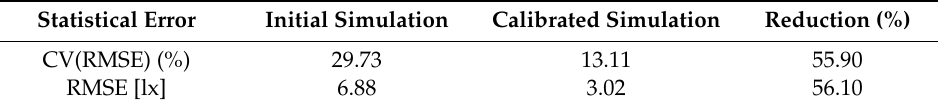
Table 5. Error estimation for the simulation of the uncalibrated and the calibrated model.